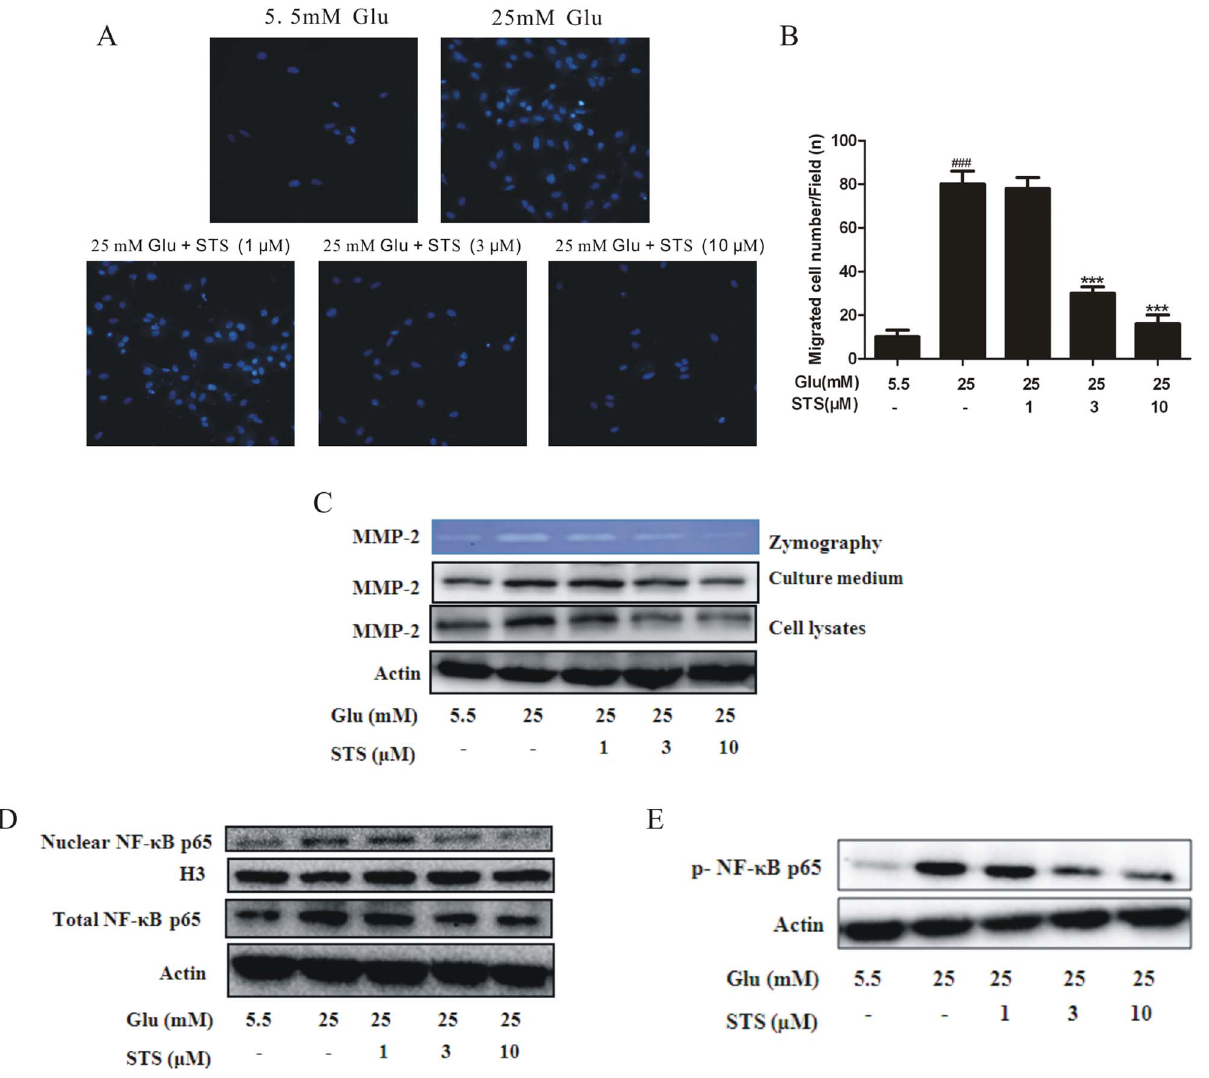
Figure 5. Effects of STS on HG-induced VSMC migration as well as MMP-2 and nuclear NF- k B. (A) Cells were treated as described in the Materials and methods section. Cells migrating to the lower surface of the membranes were fixed with 4% paraformaldehyde and stained with 2 m g/ mL Hochest33342. (B) The diagram depicts cells counted on the bottom side of the transwell chamber membrane. Values are presented as means 6 SD. ### p , 0.001 vs control. *** p , 0.001 vs HG group. (C) Quiescent cells were stimulated with HG in the presence or absence of STS for 24 h, and culture supernatants analyzed zymographically for MMP activity. Similarly, immunoblot analysis was performed with antibodies specific for MMP-2. Results are representative of three independent experiments. (D) Quiescent cells were stimulated with HG in the presence or absence of STS for 24 h, and cell lysates and nuclear extracts prepared. The levels of nuclear and total p65 were determined using Western blot. Results are representative of three independent experiments. (E) Cytoplasmic extracts were subjected to Western blot with anti-p-NF- k B p65 and b -actin antibodies. Results are representative of three independent experiments.